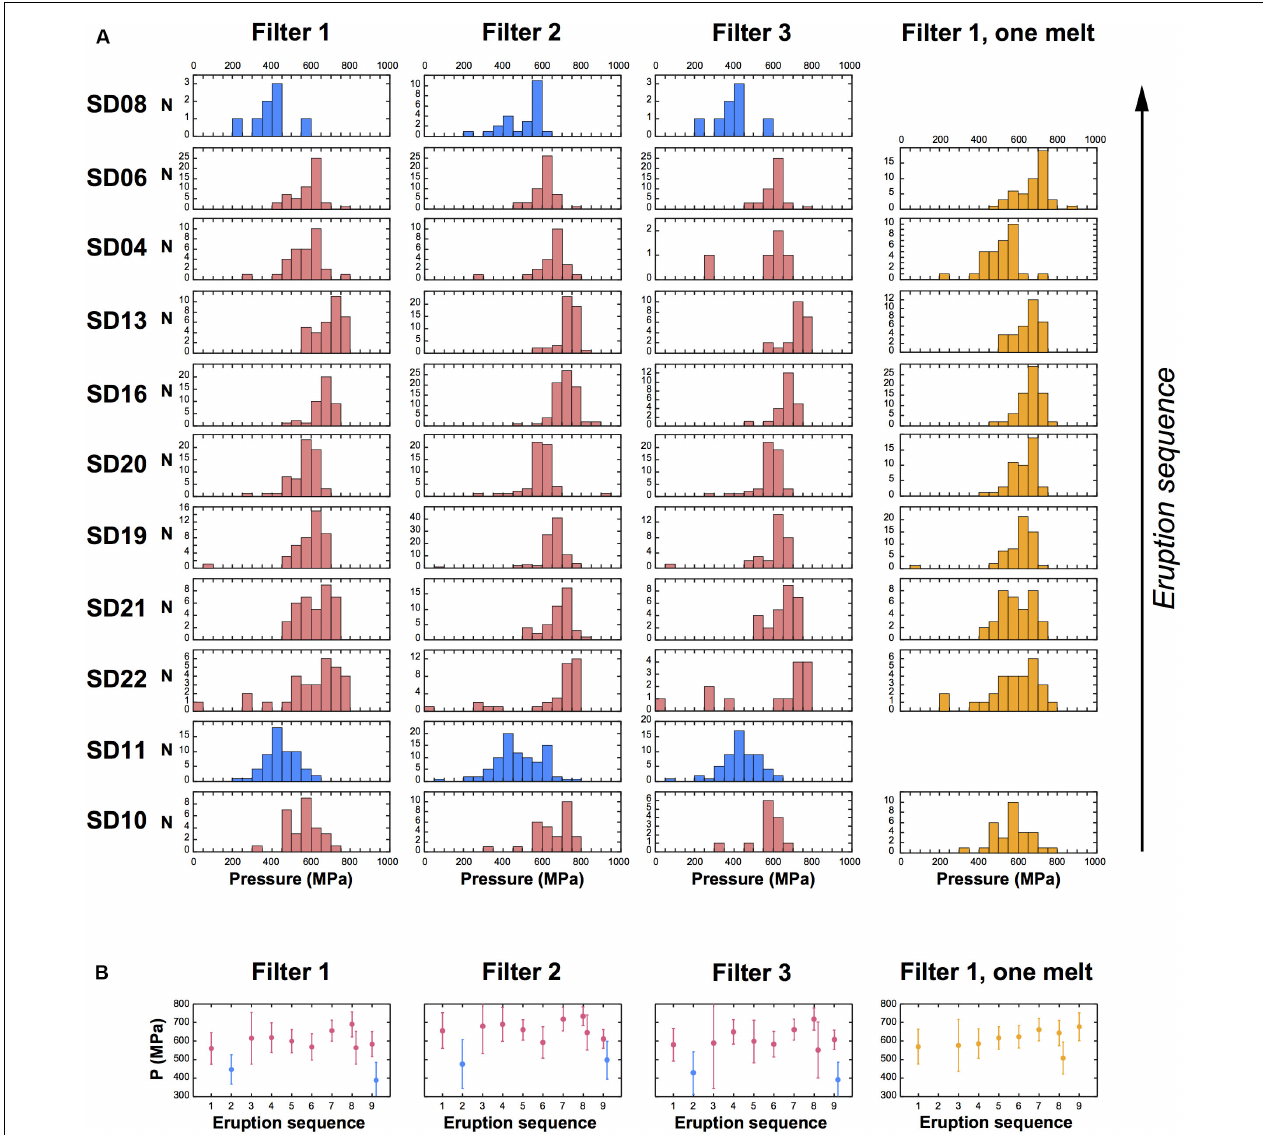
FIGURE 6 | Single-sample results of clinopyroxene-melt barometry using the Putirka et al. (2003) calibration; data were filtered as described in the text. First three columns use each sample’s groundmass composition, fourth column uses the average tephrite groundmass composition for all tephrite samples. (A) Pressures for every sample sorted by eruption sequence from bottom (oldest) to top (youngest). Note that samples SD13 and SD04 have the same sequential order based on field relations, as do samples SD06 and SD08. (B) Average pressure for every sample plotted against eruption sequence number; error bars indicate ± 1 standard deviation. The data display some inter-sample variability that is only weakly dependent of the filter